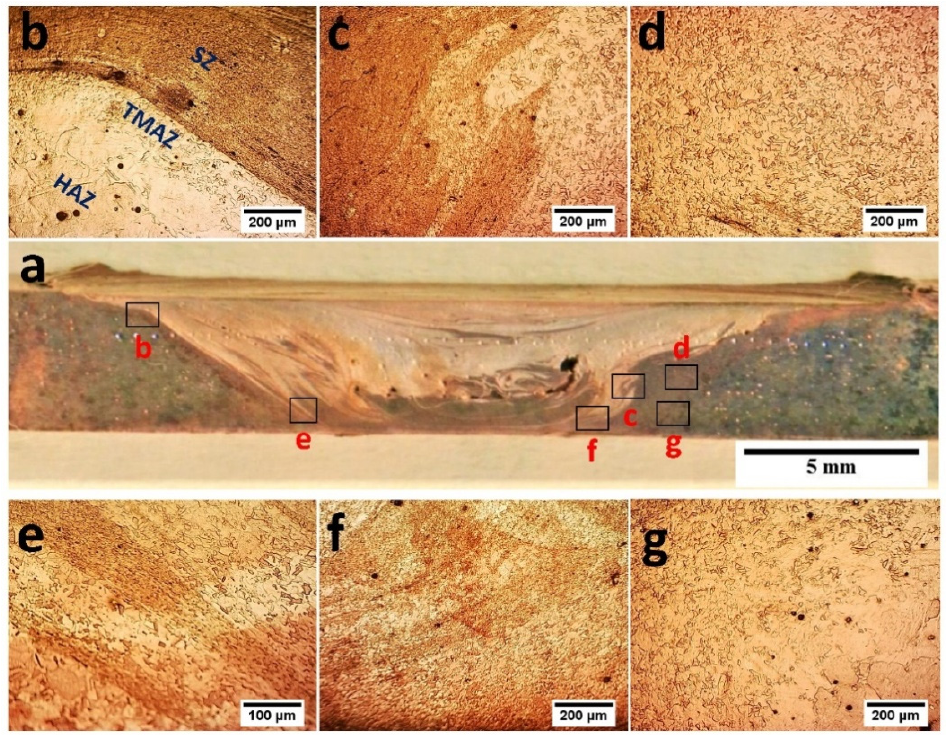
Figure 7. ( a ) Macrostructure of the alloyed region ( b ) SZ/TMAZ/HAZ Interface on shoulder affected AS ( c ) SZ/TMAZ Interface at RS ( d ) TMAZ at RS ( e ) Layered intercalations at AS ( f ) Layered intercalations at AS ( g ) TMAZ/HAZ Interface.